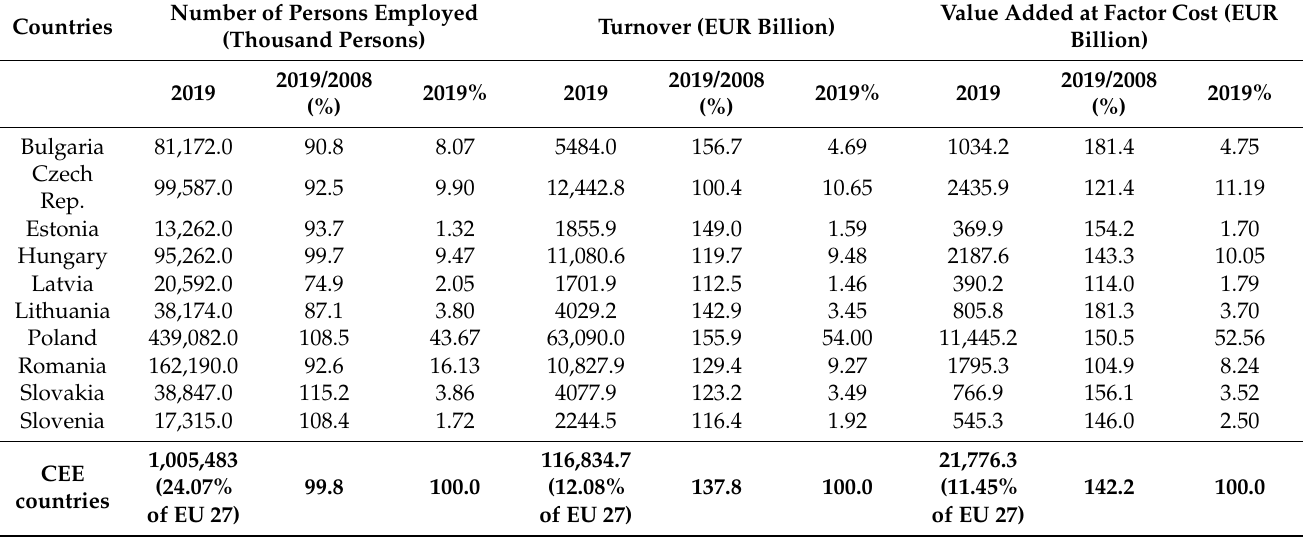
Table 4. Numbers of persons employed, turnover, and value added at factor cost—food-based bioeconomy